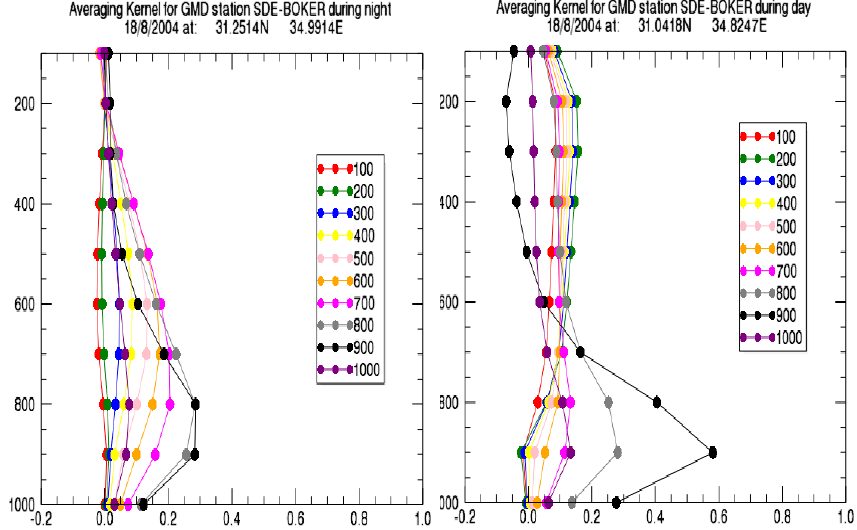
Figure 2 Averaging kernels obtained near SDE-BOKER GMD station during 18/8/2004. During day (left panel) the 900mb retrieval sharply peaks at the same level, meaning there is a good sensitivity to lower tropospheric concentration. During night (right panel) the 900mb retrieval moderately peaks at its level with same contribution from the 800mb level indicating slightly less sensitivity to the lower tropospheric concentration.